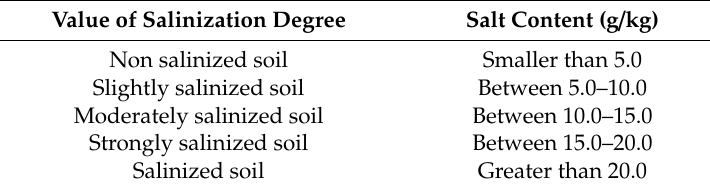
Figure 6. Spectrum reflectance of the 55 sampling points. Table 1. Soil salinization